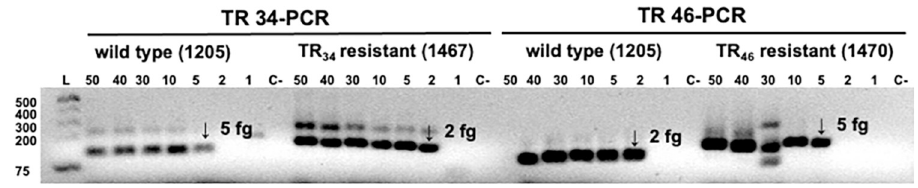
Fig 1. Detection limit of the TR34-PCR and TR46-PCR assays for Aspergillus fumigatus . The DNA from a wild type isolate (1205) and TR-based resistant isolates (1467 and 1470) were tested from 50 fg to 1 fg per reaction. The least amount of DNA detected is indicated with an arrow. Controls in the PCR assays included isolates 1205 (wt), 1467 (TR 34 ), and 1470 (TR 46 ) as positive controls and sterile distilled water as the negative control